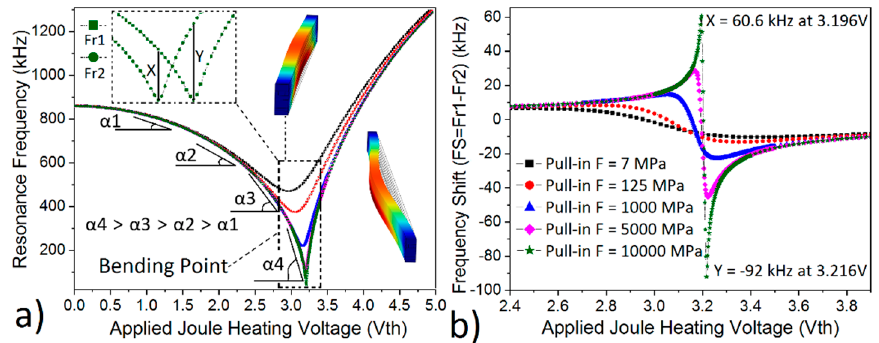
Figure 2. The effect of pull-in force (F) on the ( a ) Frequency tuning and ( b ) frequency shift (FS) in COMSOL simulation for Device 1 for a length of 120 µm long fixed–fixed beam, where Fr1 and Fr2 are the resonance frequency responses with ambient temperature of Tamb and Tamb + 1 K respectively.